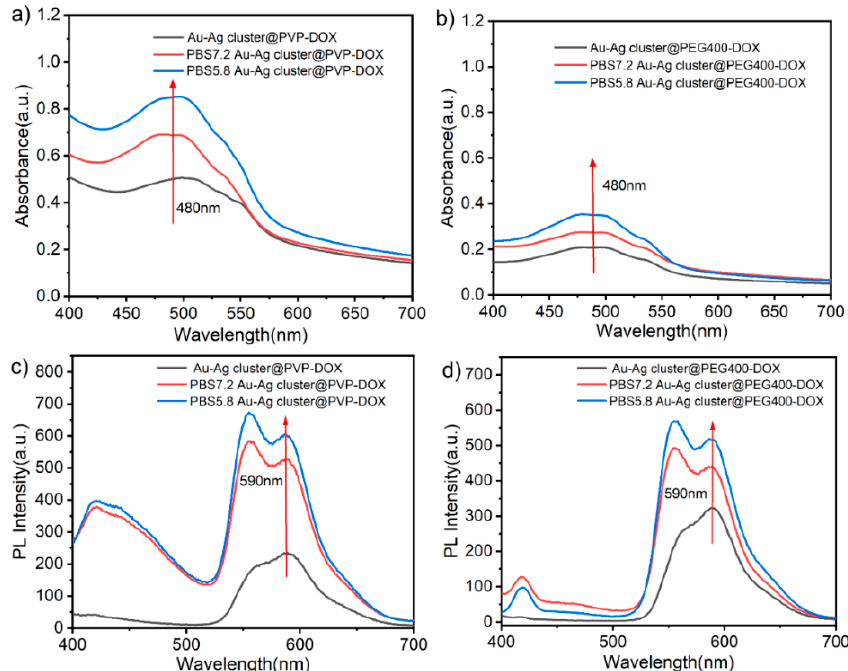
Figure 5. ( a , b ) UV-vis absorption of Au-Ag cluster @PVP-DOX, Au-Ag cluster @PEG400-DOX and it in PBS buffer at different pH value; ( c , d ) PL spectra of Au-Ag cluster @PVP-DOX, Au-Ag cluster @PEG400-DOX and it in PBS buffer at different PH.